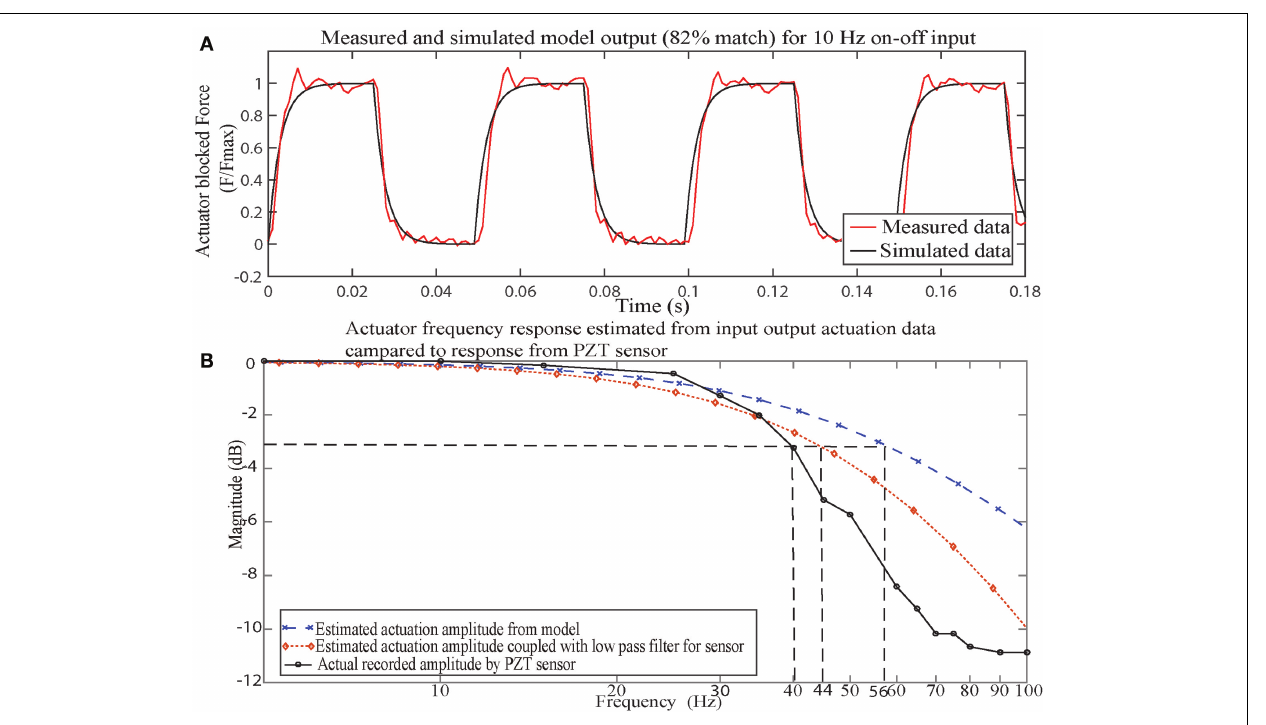
FIGURE 4 | SPA skin system vibration-control response . SPA skin actuated at 10Hz to experimentally obtain the rise-time and bandwidth of the actuator. First order dynamical system model’s output compared to experimentally recorded blocked force output at 10Hz (A) . The rise time of 0.028ms is obtained with 82% model fit. The corresponding bandwidth of 56Hz for first order transfer function compared with actual recorded bandwidth of 40Hz using PZT sensors (B) . Low pass filtering at 86Hz in PZT signal amplification coupled with estimated actuator bandwidth lowers the measured bandwidth to 44Hz from